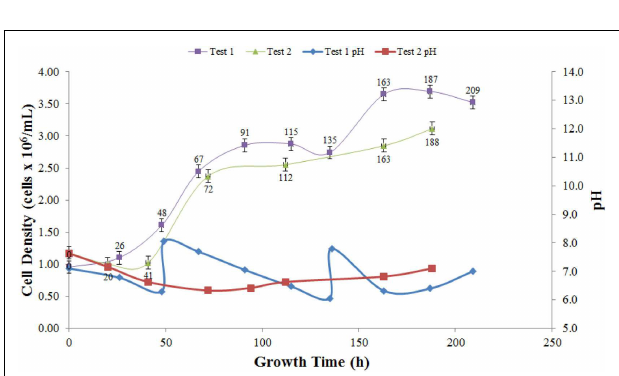
FIGURE 7 | Microalgae cell growth inTests 1 and 2 using Botanicare® media .